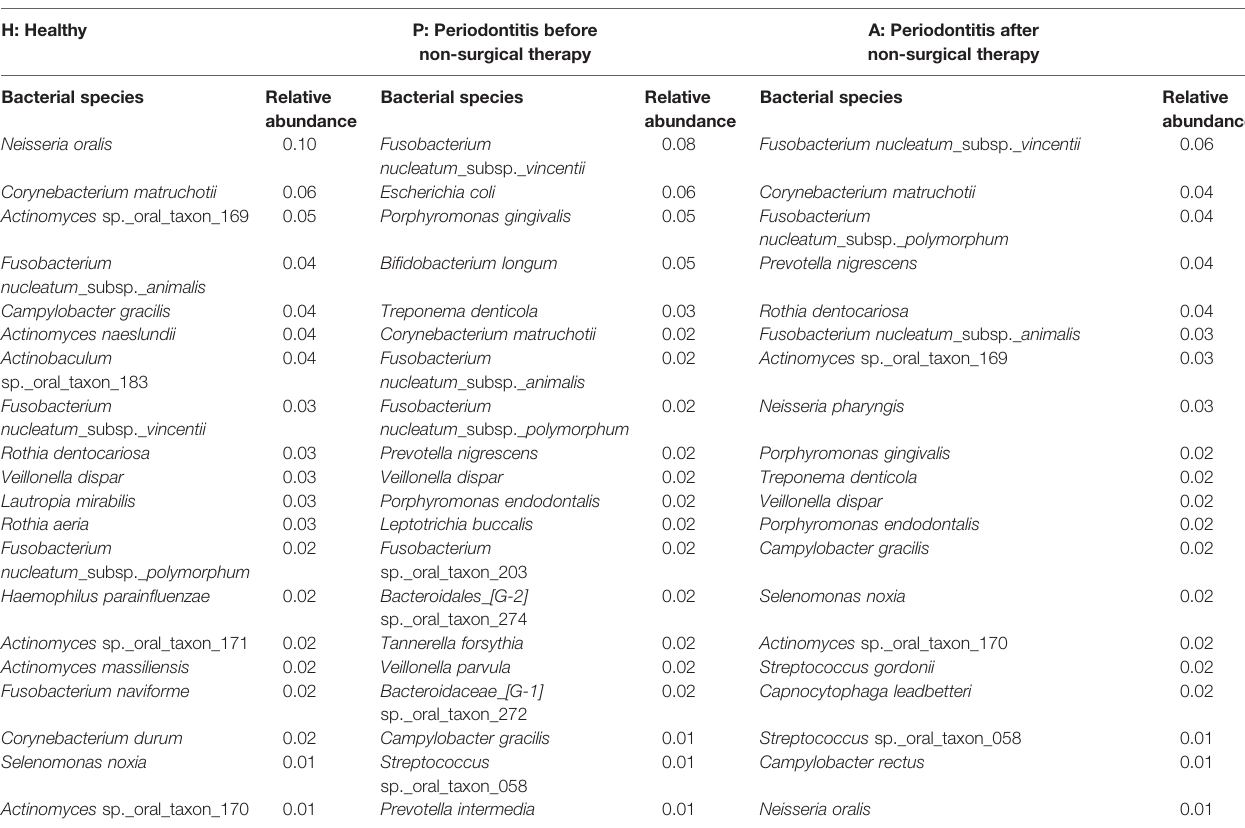
TABLE 2 | Relative abundance of bacterial species. H: